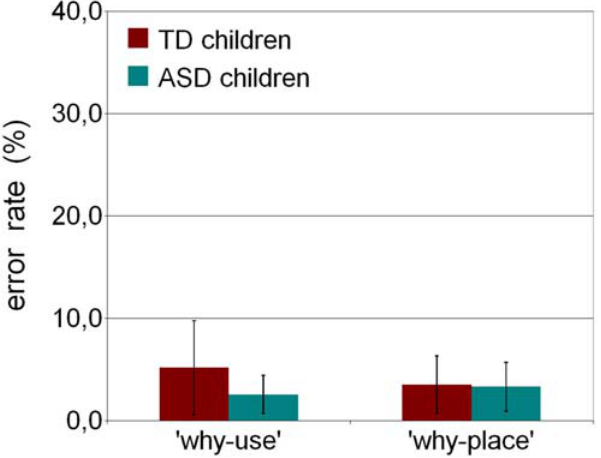
Figure 3. Results of Experiment 2. Error rates are plotted as percentage for each